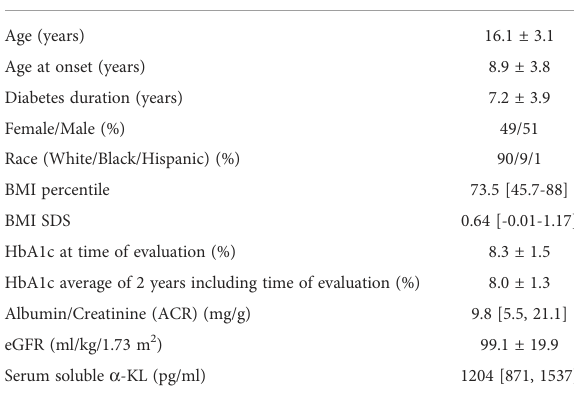
TABLE 1 Characteristics of the patient